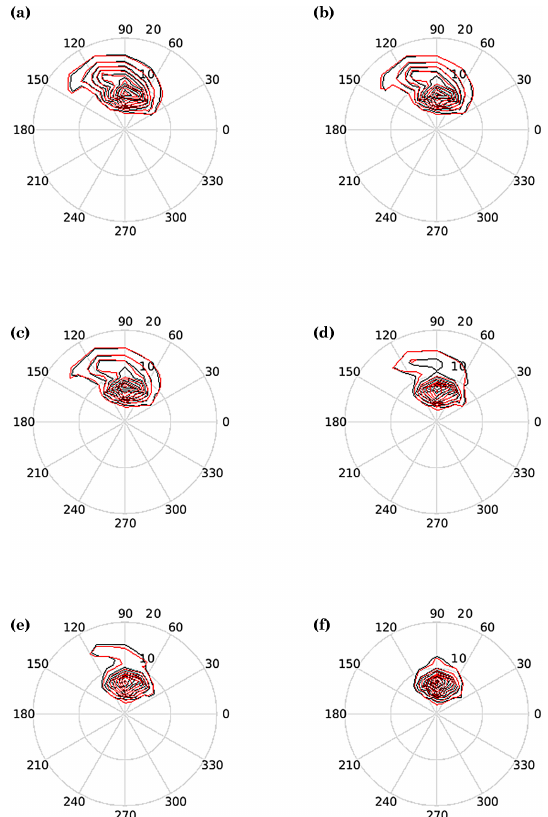
Figure 23. Polar plot of the modelled 2-D directional spec- trum (energy density, m 2 × s / degrees) in the Firth of Forth wave gauge, red indicates the contour plot of the coupled model spectrum (with WCIs incorporated), while black indicates the contour plot of the uncoupled model. Contour lines are plot- ted every 0.01m 2 sdegrees − 1 : (a) 31 March 2010 at 00:30, (b) 31 March 2010 at 01:15, (c) 31 March 2010 at 02:00, (d) 31 March 2010 at 04:15, (e) 31 March 2010 at 06:00, and (f) 31 March 2010 at 08:30UTC.